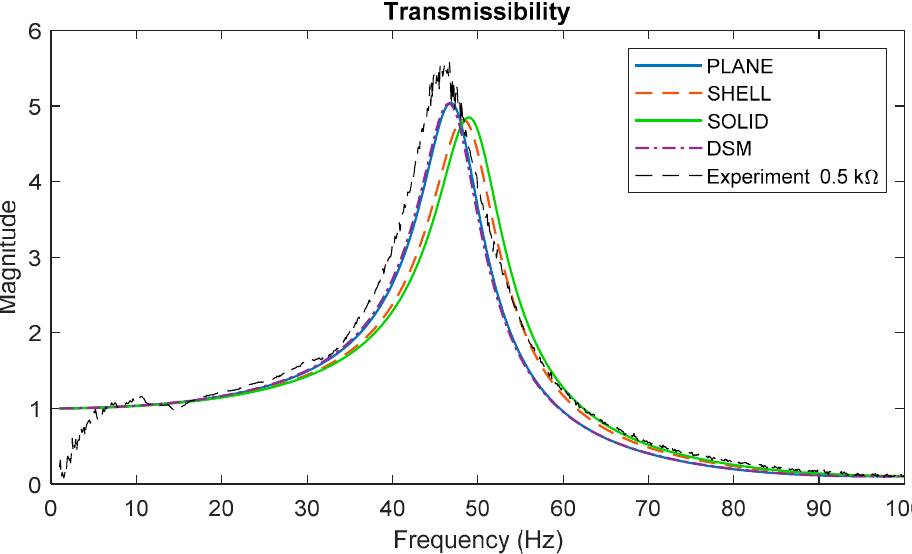
Figure 8. Predicted transmissibility using various models for the case of short-circuited load (no electrical effect), together with the experimental transmissibility obtained at the lowest resistance considered (close to short circuit).